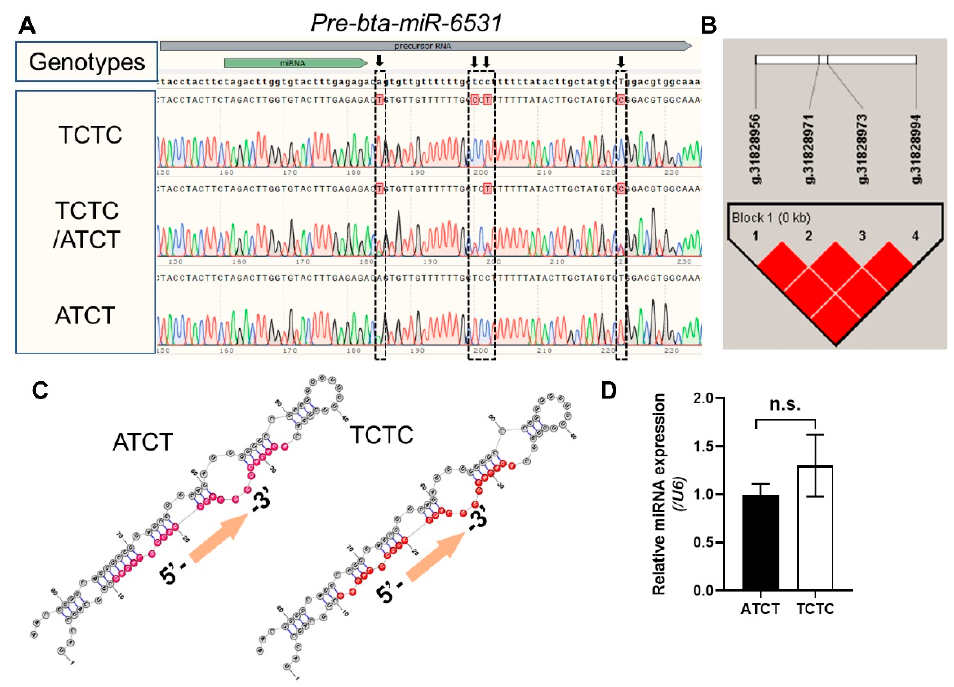
Figure 5. SNPs distribution within the bta ‐ miR ‐ 6531 precursor. ( A ) The four SNPs located within the precursor sequence of bta ‐ miR ‐ 6531. ( B ) The four SNPs showed s strong link with each other. ( C ) The four SNPs did not significantly change the structure of bta ‐ miR ‐ 6531 precursor. ( D ) The miR ‐ 6531 expression in sperms with high and low motility.